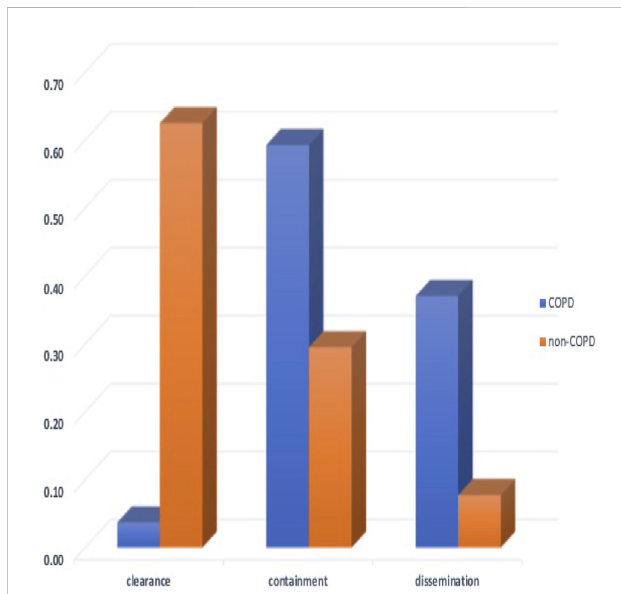
FIGURE 6 The probability distribution of qualitative outcomes for the ABM- PHYS model of Mtb infection for non-COPD individuals [which is concurrent with the distributions of outcomes for in vivo non-human primatemodelsofTBusingdatafrom(Linetal.,2014;Gideonetal., 2015)]and thedistributionofqualitativeoutcomesfor COPD individuals. The two probability distributions are signi fi cantly different (p < 0.001) with the COPD Mtb infection model resulting in approximately four times more dissemination outcomes compared to dissemination outcomes for the non-COPD